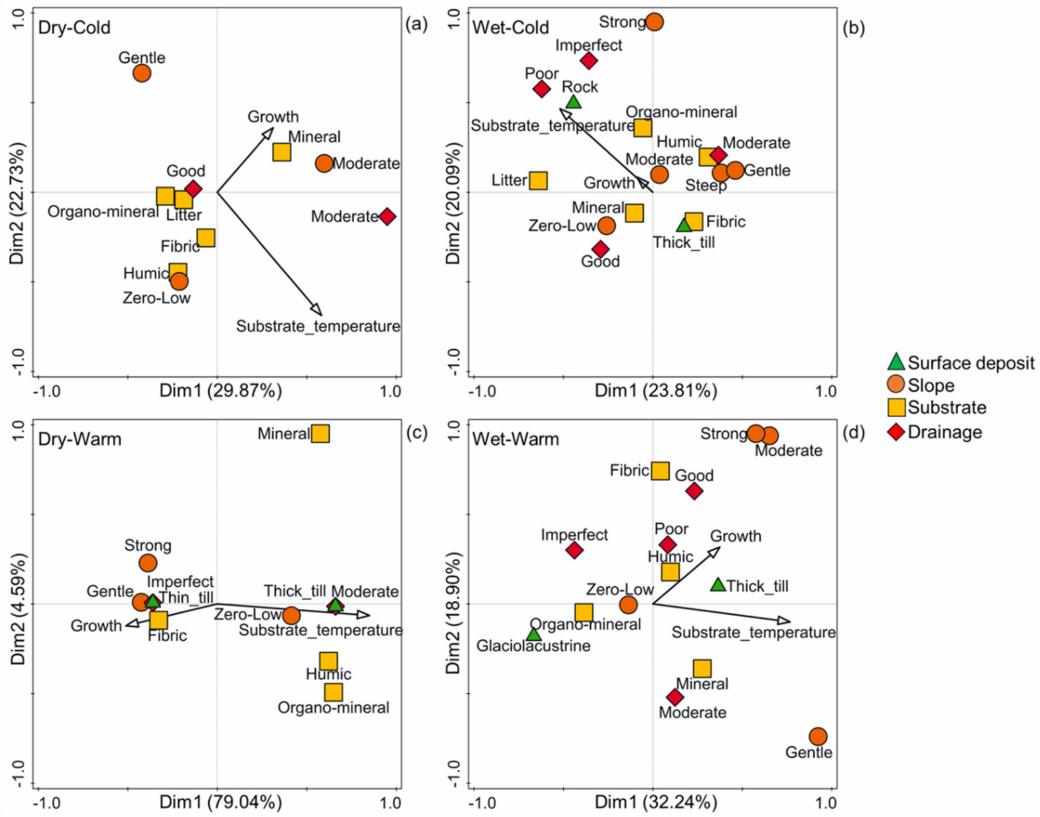
Figure 2. Principal component analysis (PCA) summary of black spruce growth responses to local variables at the microsite level and soil variables at the stand level, within four regions that are delineated by annual precipitation and average temperature: ( a ) Dry–Cold; ( b ) Wet–Cold; ( c ) Dry–Warm; and ( d )